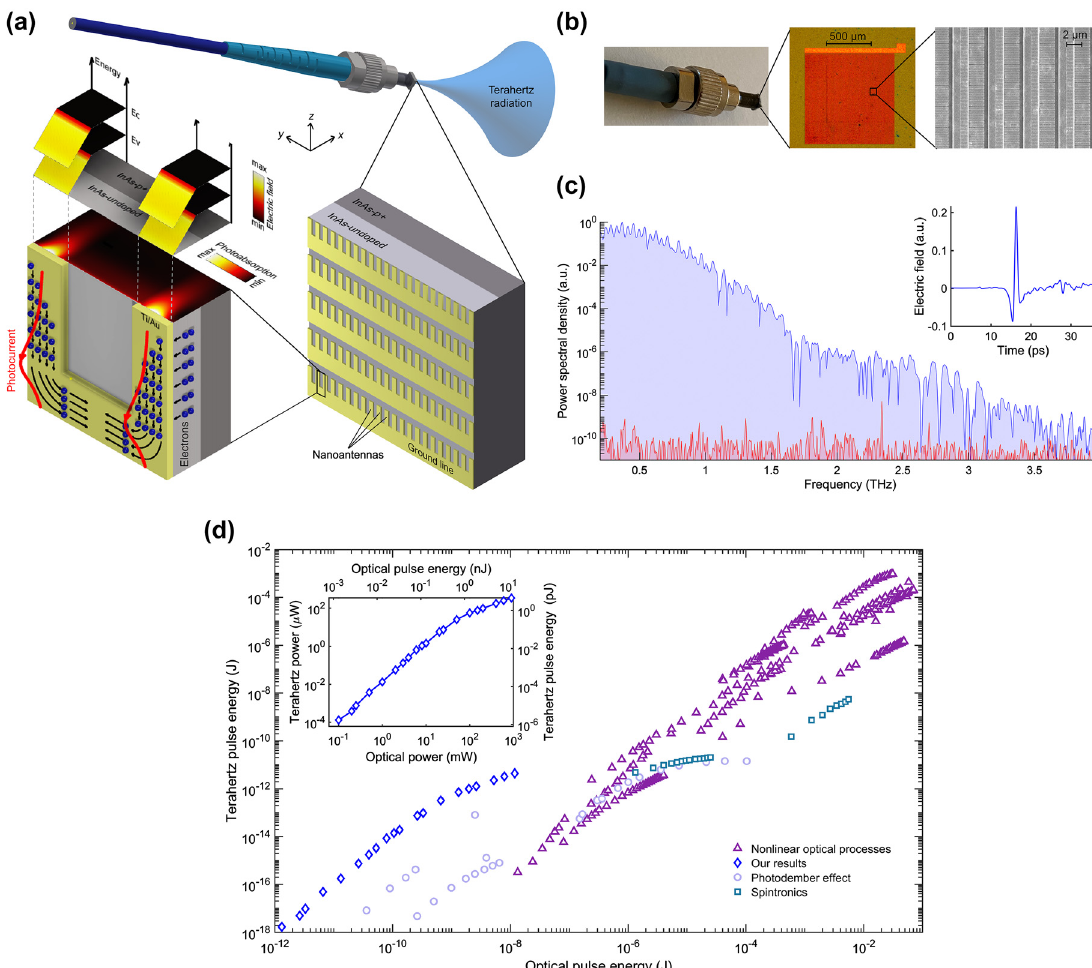
Figure 11: (a) Schematic ofthe bias-freeterahertz emitter based onplasmon-coupled surfacestates.(b) Photograph,microscopy,andscanning electron microscopy images of a fabricated emitter prototype. (c) Measured terahertz radiation power (in blue) and noise (in red) spectra generated from the fiber-coupled emitter. (d) Measured terahertz pulse energy/power from the fabricated emitter as a function of the optical pulse energy/power (inset) in comparison with other passive optical-to-terahertz converters reported in the literature. Adapted from